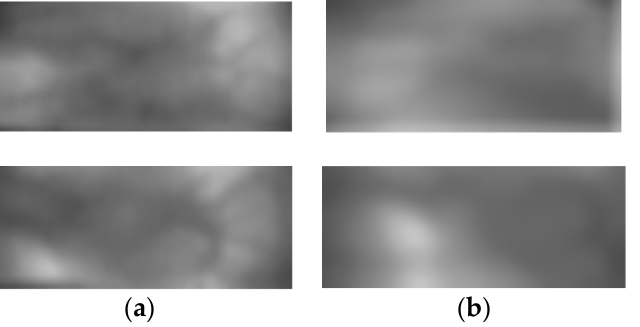
Figure 7. Examples of finger-vein images captured in a real environment. ( a ) Original images, ( b ) blurred images.